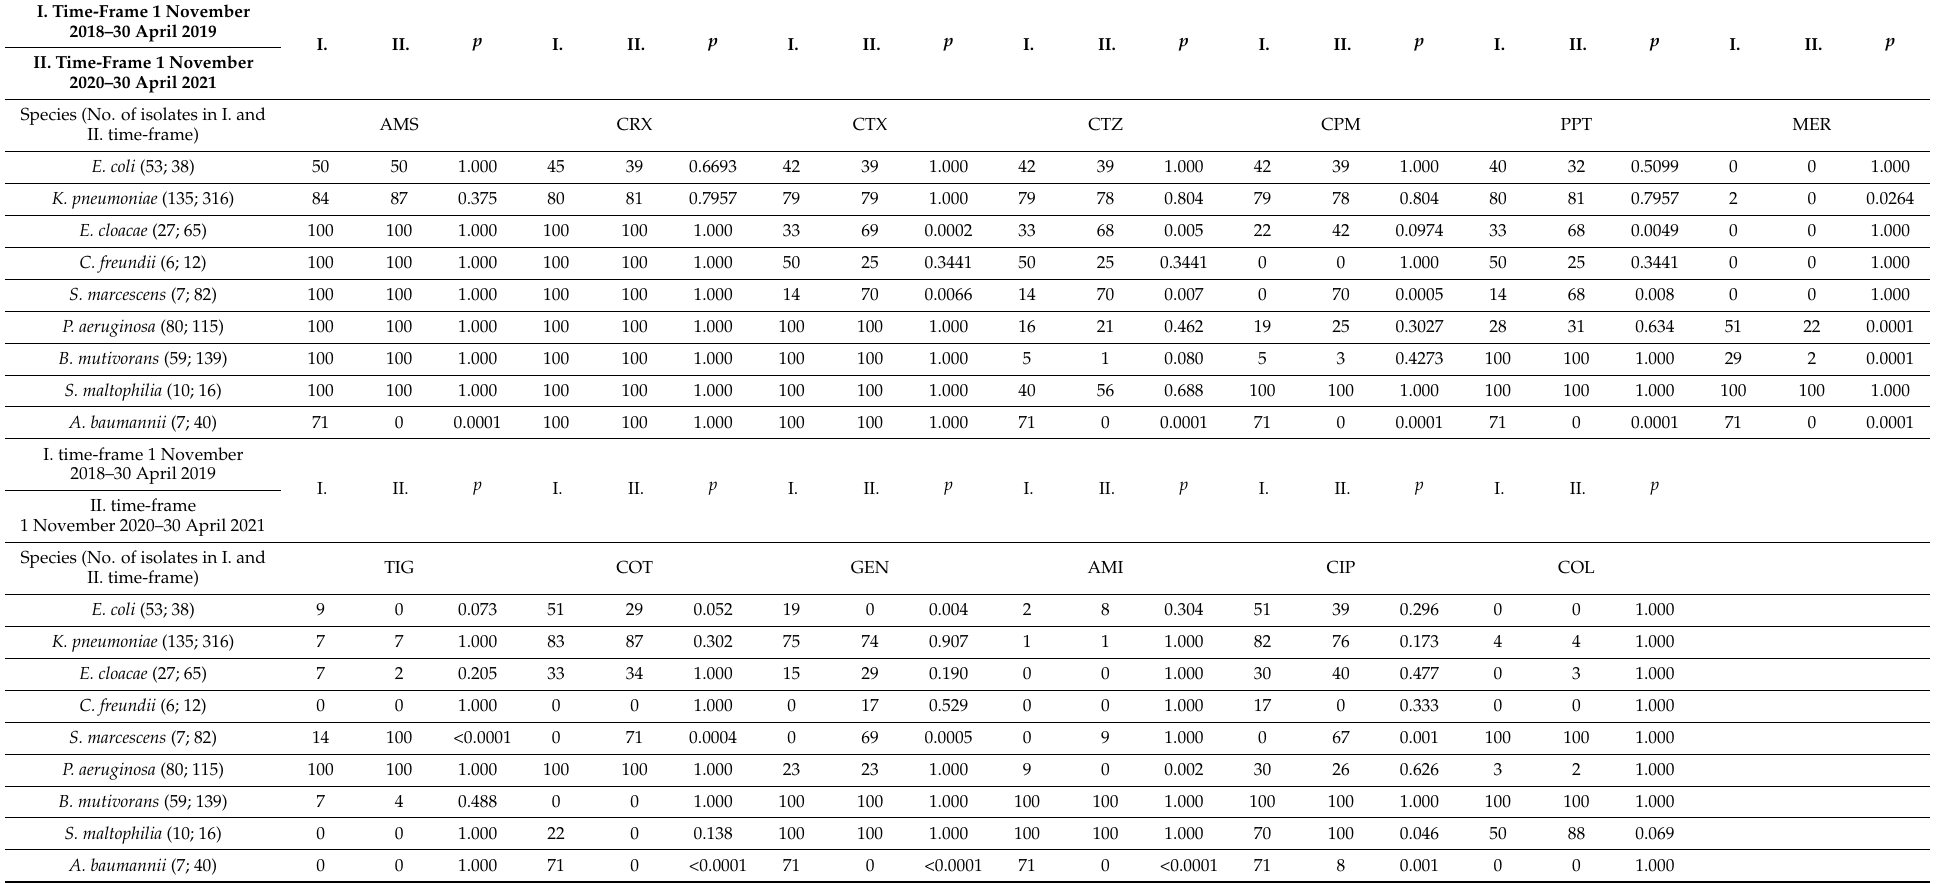
Table 3. Bacterial resistance to antibiotics (percentages) before (I) and during (II) the COVID-19